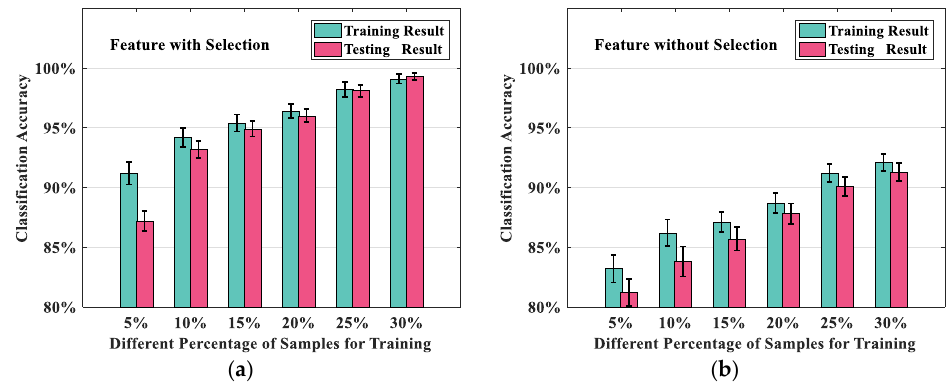
Figure 6. Comparison of the accuracy of the SVM and artificial neural network (ANN) classifiers with different training percentage. ( a ) classification accuracy with feature selection in Fisher score; ( b ) classification accuracy without feature selection.